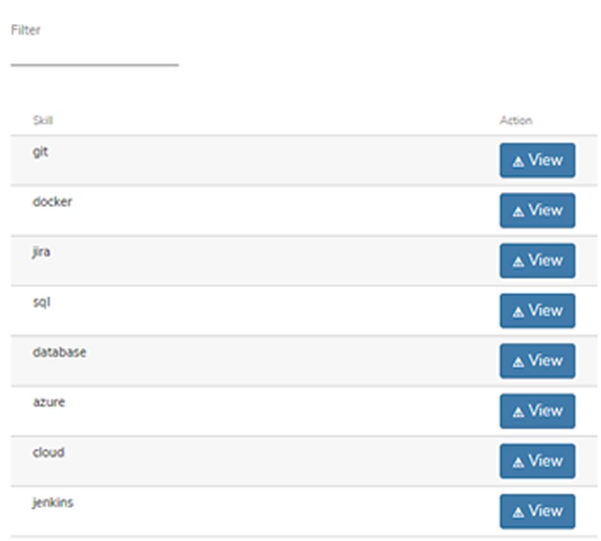
Figure 4. Recommended